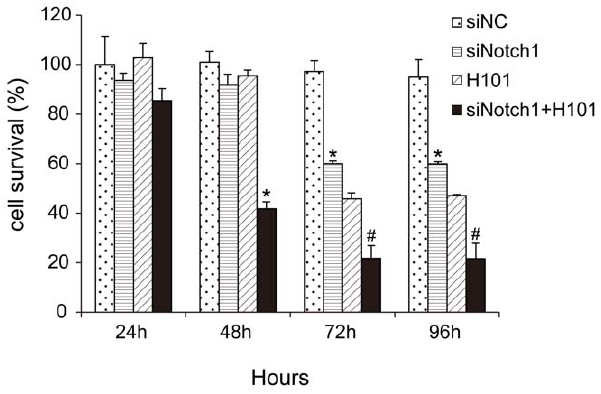
Figure 2. Cell proliferation of HeLa-S3 cells following the combined treatment of Notch1-siRNA and H101. Cell prolifera- tion was measured by MTT assays 24, 48, 72, 96 hours after co- treatment of Notch1-siRNA (100 nmol/l) and 24, 48, 72 hours after H101 infection (multiplicity of infection (MOI) =100). All data are presented as means 6 SD of three independent experiments. *p , 0.05, # p , 0.01 as compared with negative control.